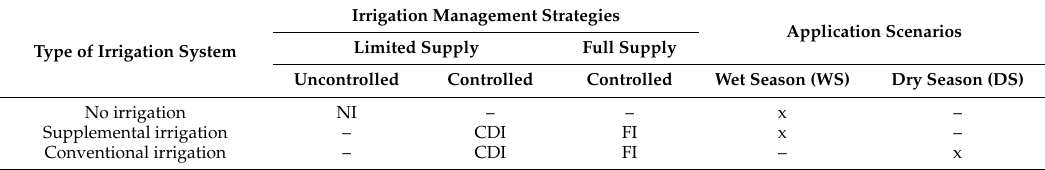
Table 1. Irrigation management strategies